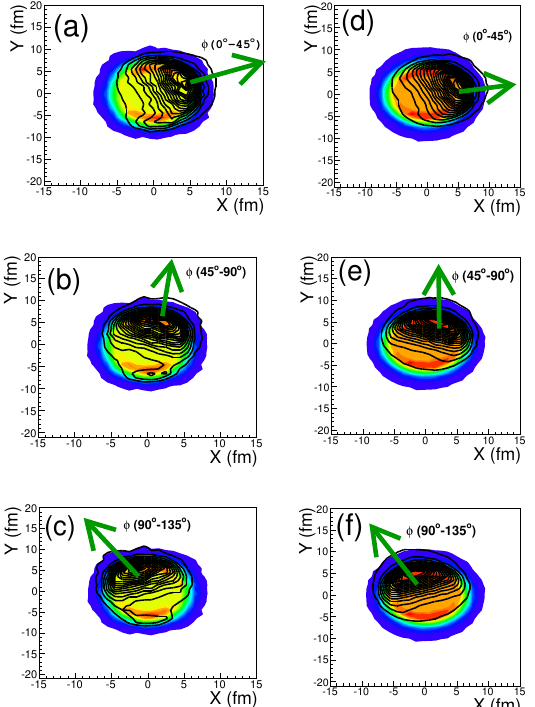
Figure 5. Pion emission function in the transverse plane of HYDJET++ simulated Pb + Pb collisions at √ s = 2.76 TeV with centrality 20–30%. The left column displays calculations with only spatial elliptic anisotropy ε 2 = 0.5, whereas the right column presents results for non-zero dynamical anisotropy δ 2 = − 0.3. Shaded contours are identical for each column and indicate the density of emitted pions. Contour lines show the densities of pions emitted at angles 0 < φ ≤ π /4 ( upper row ), π /4 < φ ≤ π /2 ( middle row ), and π /2 < φ ≤ 3 π /4 ( bottom row ),